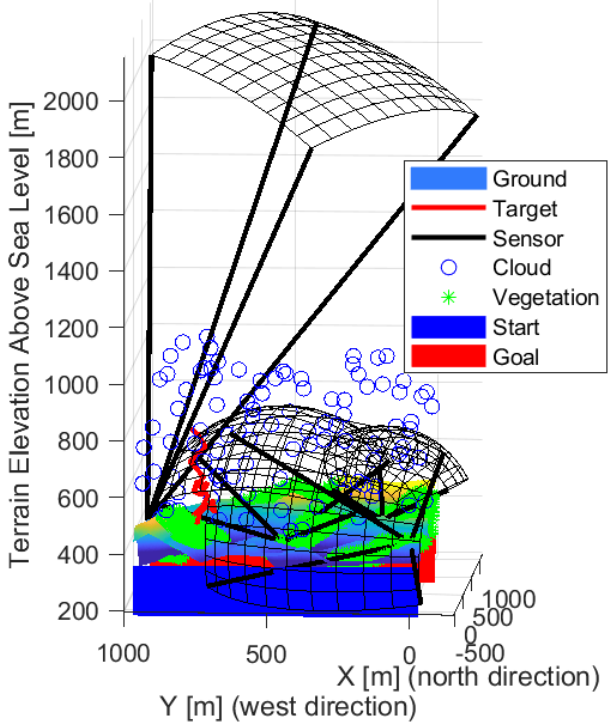
Figure 12. The solution in the case of the four sensors front-wise.